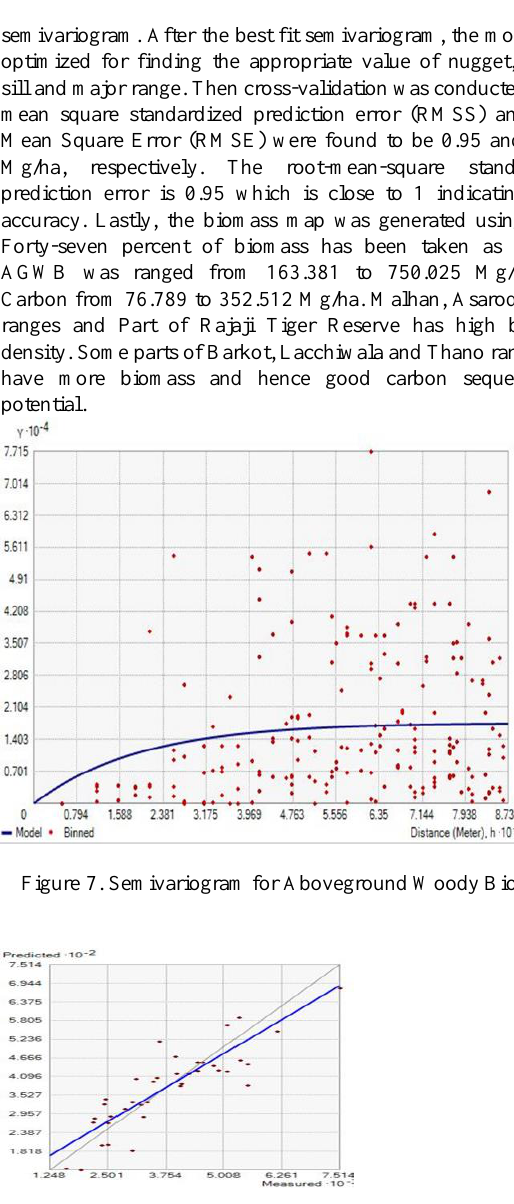
Figure 8. Graph for predicted aboveground woody biomass.